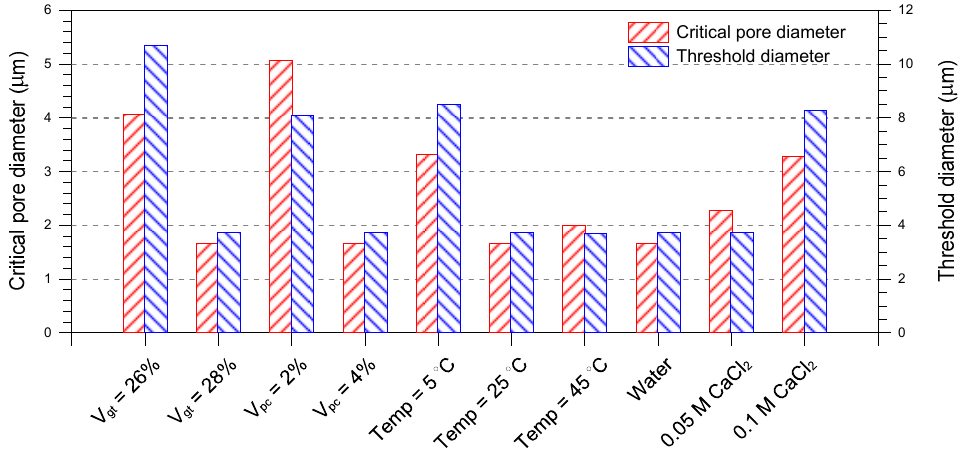
Figure 6. Effect of CaCl 2 concentration on pore size distribution of cement-stabilized tailings: ( a ) cumulative intrusion curve, ( b ) differential instruction curve.